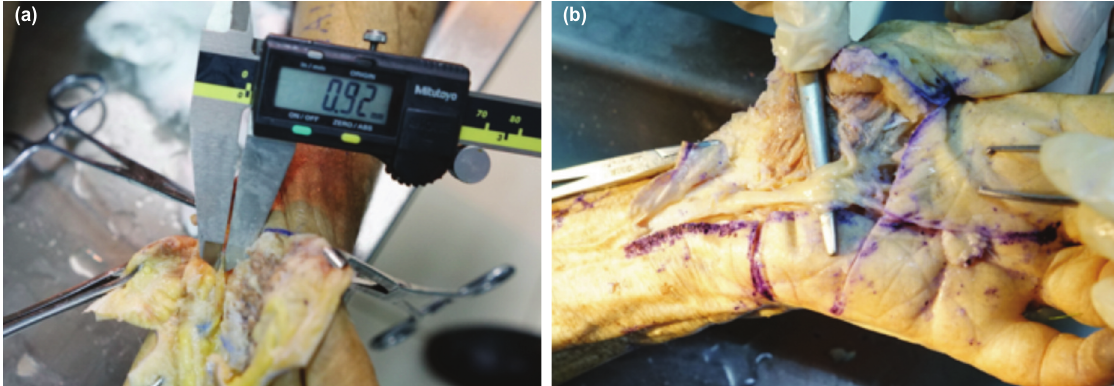
(a) Transverse carpal ligament thickness measurement. (b) Exposing the median Fig. 4: